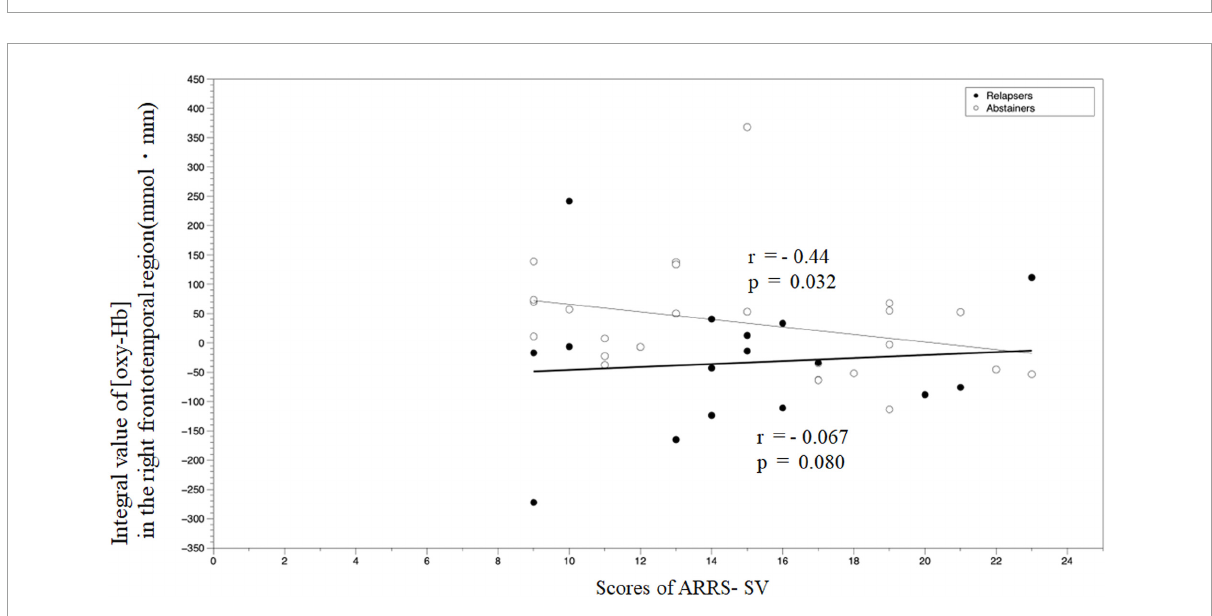
FIGURE7 A correlation analysis of the integral value of (oxy–Hb) in the right frontotemporal region during the emotional go/no-go task and ARRS-SV. ARRS-SV, alcohol relapse risk scale-stimulus-induced